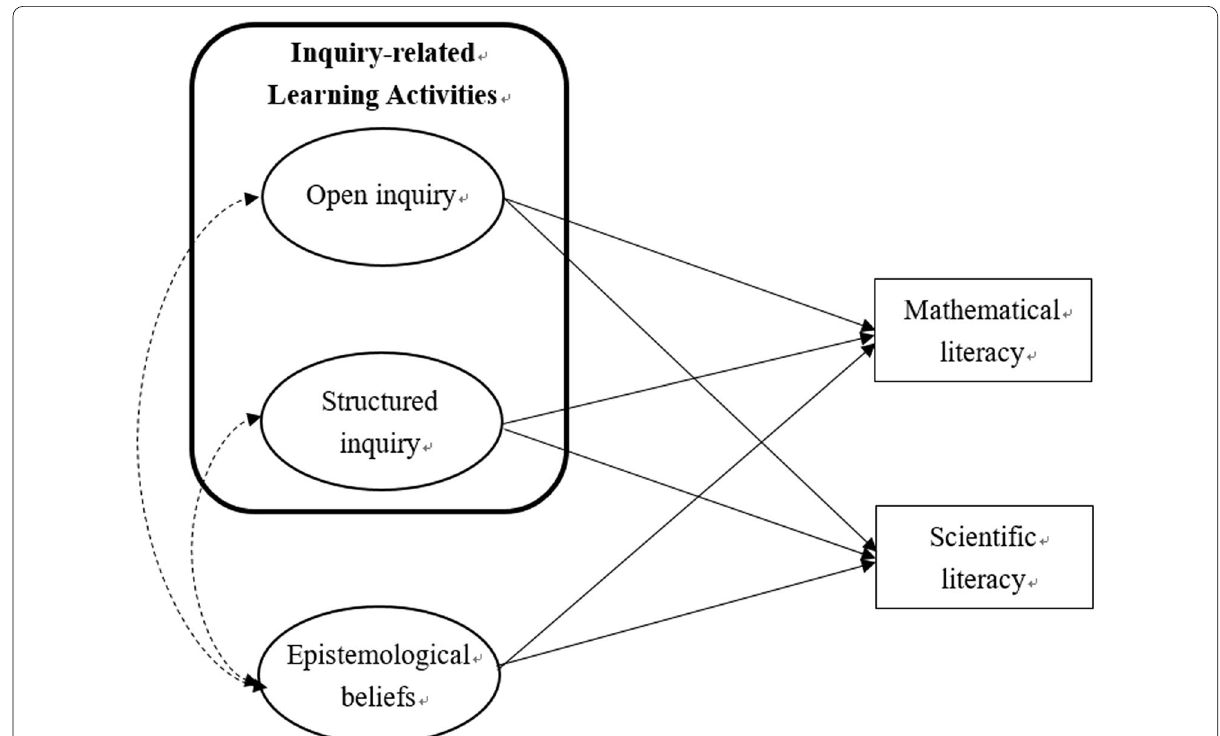
Fig. 1 Theoretical model of inquiry‑related learning activities, epistemological beliefs, scientific and mathematical competencies. The dashed line indicates that there may be a potential correlation between the two